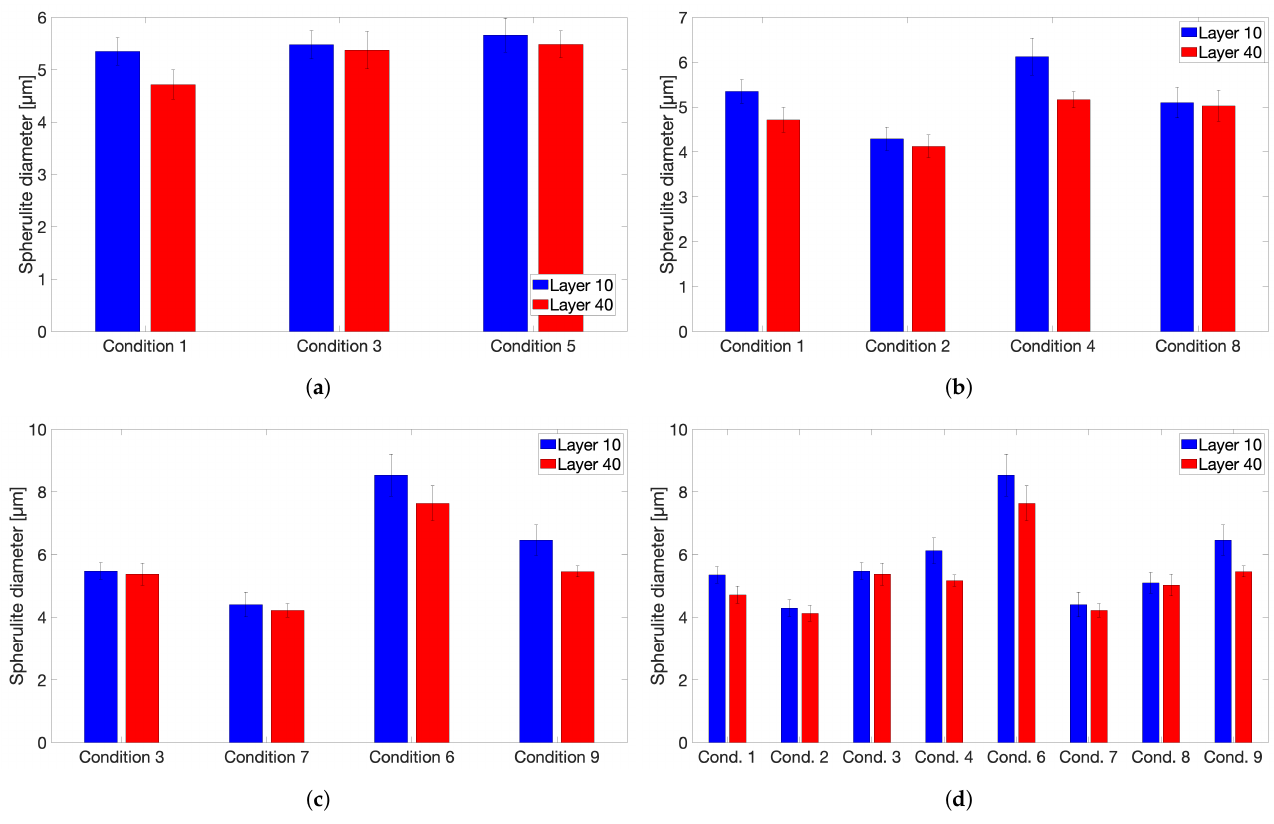
Figure 12. An overview of the measured spherulite diameters for all printing conditions. ( a ) Effect of T liquefier = 260, 240 and 220 °C for conditions 1, 3 and 5, respectively. ( b ) Effect of v print = 11 mm/s for conditions 1 and 2, and 5.5 mm/s for conditions 4 and 8. ( c ) Effect of M w . HMWPA for conditions 3 and 7 and LMWPA for conditions 6 and 9. ( d ) Effect of T build plate = 110 °C for conditions 1, 3, 4 and 6, and 40 °C for conditions 2, 7, 8 and